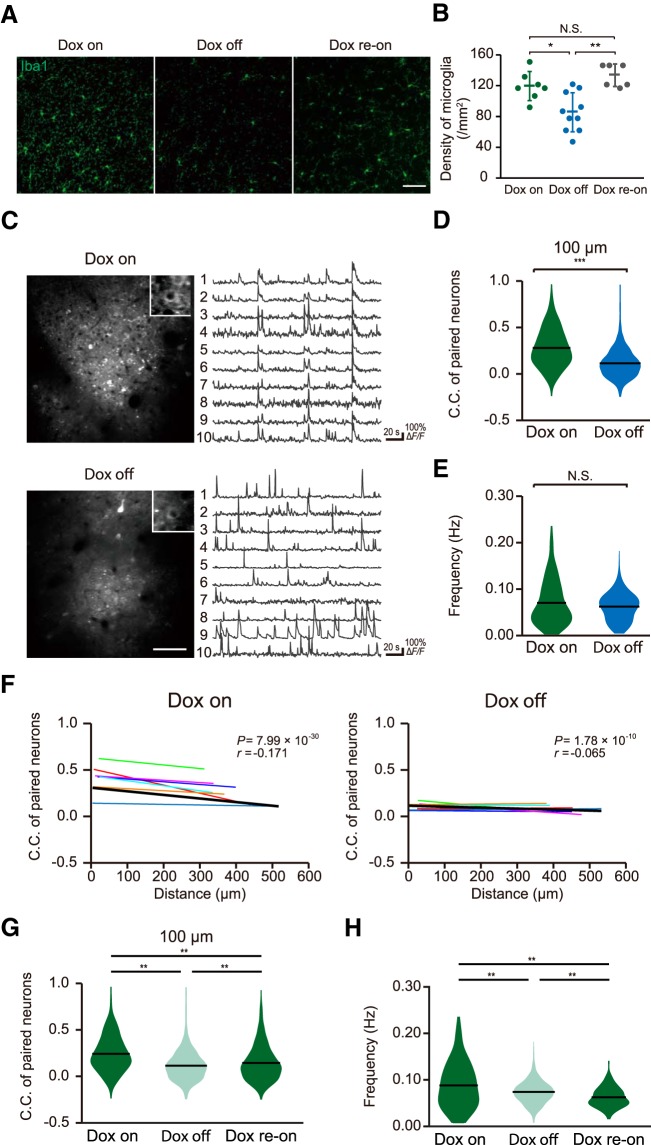
Decreased synchronization of evoked neural activity in microglia ablated mice. A, Fluorescent (immunohistochemistry) images of Iba1-positive microglia in cortical sections of Dox on (left), Dox off (center), and re-Dox on mice showing reduced density of Iba1 (microglia)-positive cells in Iba1-tTA::tetO-DTA transgenic mice following 7 d of Dox withdrawal as compared with Iba1-tTA::tetO-DTA transgenic mice with Dox maintained in the diet and in Dox-off mice after Dox had been returned to the diet for a week (Dox re-on). Scale bar in right panel: 50 μm. B, Genetic ablation of microglia was verified by quantification of microglia density. Dox-off mice showed a significant reduction in the density of microglia from 121.3 ± 18.7/mm2 (n = 7 fields from three Dox on mice) to 87.4 ± 25.1/mm2 (n = 10 fields from three Dox-off mice; p = 0.006, unpaired t test). The density of microglia recovered to control levels following one week of Dox return to the diet (135.0 ± 14.5/mm2, n = 6 fields from three Dox re-on mice; p = 0.0008, unpaired t test). C, left, Typical fields of view of L2/3 primary motor cortex neurons expressing GCaMP6f in Dox on mice (upper) and Dox off mice (lower). Right, Representative ΔF/F Ca2+ traces from individual GCaMP6f-positive neurons from Dox on (upper) and Dox off mice (lower). D, Synchronous neuronal firing was estimated by measuring the proportion of neuron pairs in which Ca2+ transients were seen at the same time, and quantifying this as a C.C. The mean C.C. of paired neurons within 100 μm of each other was lower in Dox off mice as compared with that in Dox on mice [Dox on mice (n = seven mice); 0.28 ± 0.006, Dox off mice (n = 7 mice); 0.12 ± 0.003, p = 1.75 × 10−171, Wilcoxon rank sum test]. E, There was no difference in the frequency of Ca2+ responses between Dox on and Dox off mice [Dox on (n = 269 neurons from seven mice); 0.071 ± 0.003 Hz, Dox off (n = 326 neurons from seven mice); 0.062 ± 0.002 Hz, p = 0.463, Wilcoxon rank sum test]. F, The C.C.s in each pair of neurons was negatively correlated with the distance separating each pair of neurons in control (Dox on) mice (left). However, this negative correlation was absent in Dox off mice (right). Individual slope correlations from each mouse are shown by the thin colored regression lines, while the thicker black line shows the correlation obtained by fitting all the data simultaneously. The value of the slope of this group correlation and the p value obtained from the Pearson’s correlation test are shown in the top right of each graph, while averaged slope values obtained from each mouse are shown in this legend (control mice: n = 7, r = –0.171, p = 7.99 × 10−30; microglia ablated mice: n = 7, r = –0.065, p = 1.78 × 10−8, Pearson’s correlation test; for seven Dox on mice, r = –0.175 ± 0.045, p = 0.0082, one-sample t test; for seven Dox off mice, r = –0.048 ± 0.036, p = 0.227, one-sample t test). G, H, In an additional cohort of mice, the C.C.s of neurons located within 100 μm of each other (G) and the neuron firing frequencies (H) were measured during the doc on diet (left), following 7 d of Dox off diet (center) and again 42 d after returning to dox diet (dox re-on, right). Dox-off again reduced the C.C. which partially recovered after returning to dox [G: F(2,4926) = 200.21, p = 9.56 × 10−10 (Dox on: 0.243 ± 0.006 vs Dox off: 0.115 ± 0.003), p = 3.15 × 10−7 (Dox off: 0.115 ± 0.003 vs Dox re-on: 0.145 ± 0.005), p = 9.56 × 10−10 (Dox on: 0.243 ± 0.006 vs Dox re-on: 0.145 ± 0.005), one-way ANOVA followed by Tukey’s test]. The neuronal firing frequencies in this cohort were decreased after Dox off and decreased further after returning to dox on [H: Dox on (n = 165 neurons, four fields from two mice); 0.088 ± 0.004 Hz, Dox off (n = 229 neurons, four fields from two mice); 0.074 ± 0.001 Hz, Dox re-on (n = 211 neurons, four fields from two mice); 0.063 ± 0.001 Hz, F(2,602) = 29.19, p = 5.83 × 10−5 (Dox on vs Dox off), p = 5.15 × 10−4 (Dox off vs Dox re-on), p = 9.56 × 10−10 (Dox on vs Dox re-on), one-way ANOVA followed by Tukey’s test]. Data in panel B are presented as the mean ± SEM, while data in panels D, E, G, H show means and distributions of each data point; *p < 0.05, ***p < 0.001, n.s.: non-significant.